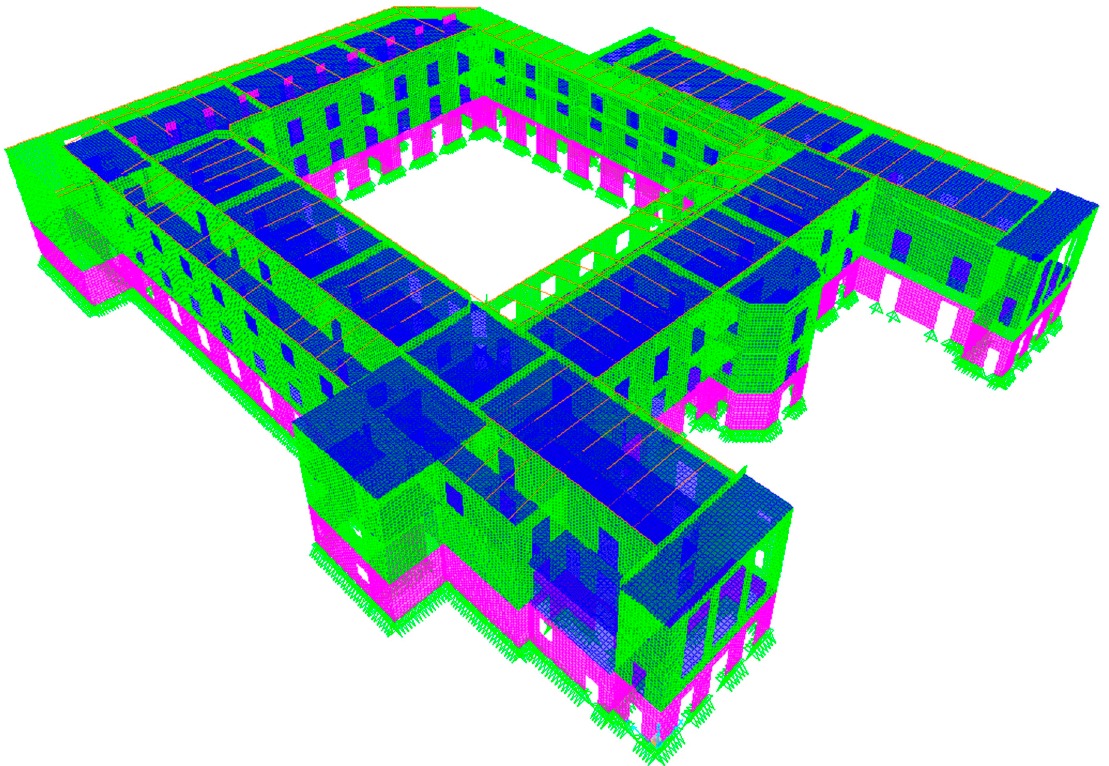
Figure 7. Three-dimensional finite element model of Bagh Figure 7. Three ‐ dimensional finite element model of Bagh Durbar.